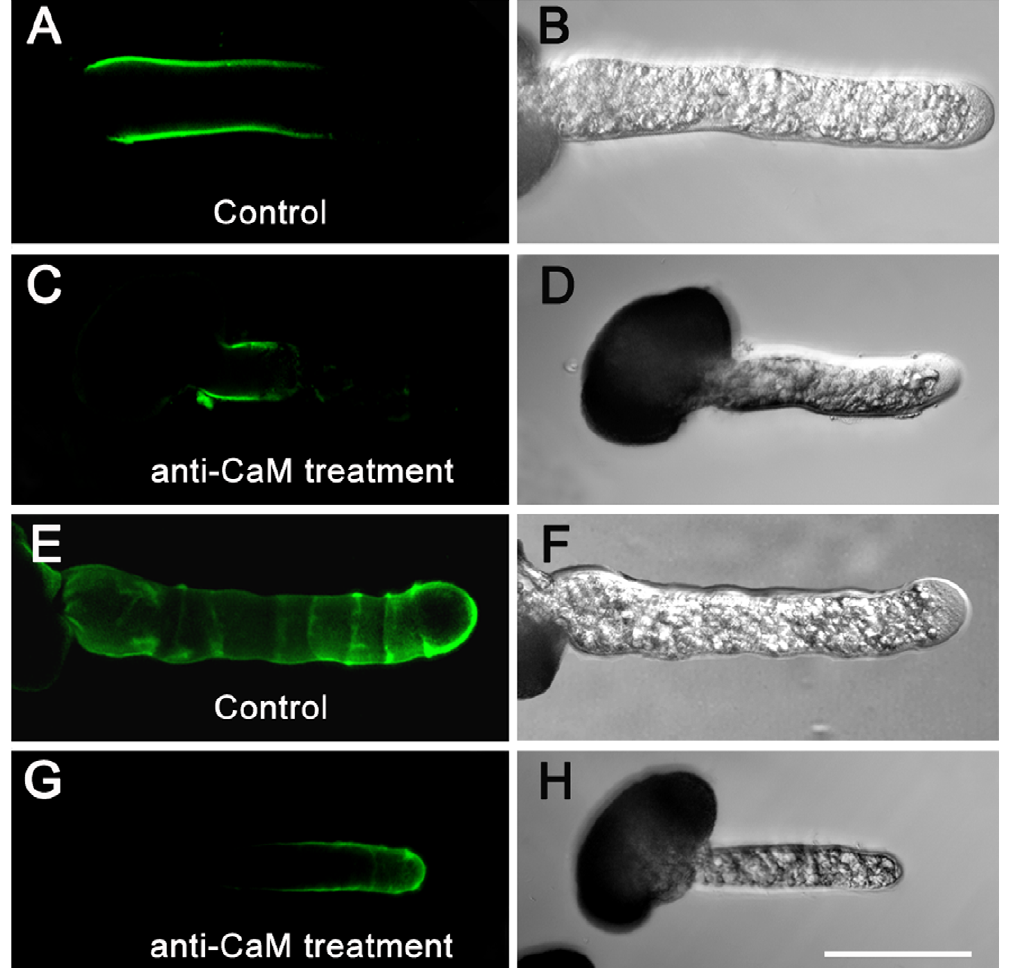
Figure 7. Deposition of LM2- and LM6-reactive AGPs in control and anti-CaM-treated pollen tubes. Immunolabeling of AGPs in pollen tube wall and subsequent image collection were carried out following procedures for pectin labeling except that LM2 and LM6 were used as primary antibodies. Pollen tubes were mounted and photographed under an LSCM (excitation, 488 nm; emission, 522 nm). Controls were prepared by omitting primary antibody. Samples consisted of 50 m L cultured pollen tubes (1 mg/mL at beginning of pollen culture) for immunofluorescence labeling experiments (repeated for three cultured sample bulks), of which five to nine pollen tubes were used for image collection and subsequent data analysis. A–B, Increasing gradient of LM2-reactive AGPs from subapical region to basal part of control pollen tubes. C–D, Fluorescence of LM2- reactive AGPs gradient was confined to basal part and did not extend further toward tip after anti-CaM treatment. E–F, LM6-reactive AGPs distributed in characteristic ring-like pattern similar to that of JIM5-reactive pectins along entire tube length of control pollen tubes. G–H, LM6-reactive AGPs were detected along tube shank and tip region after anti-CaM treatment, but characteristic ring-like pattern was abolished. Bar=50 m m.